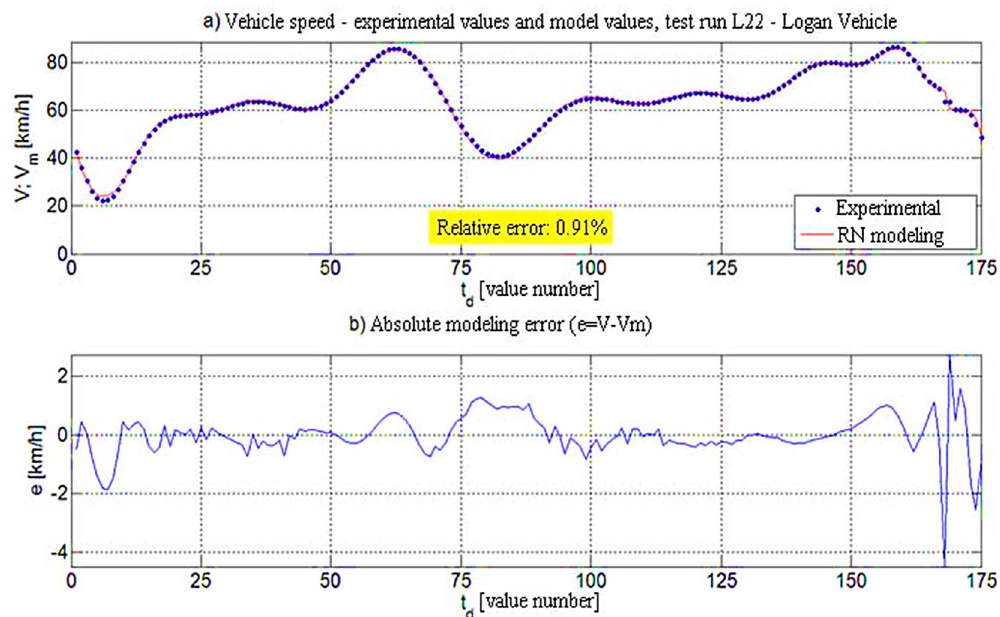
Figure 4. Comparison between real data and simulation